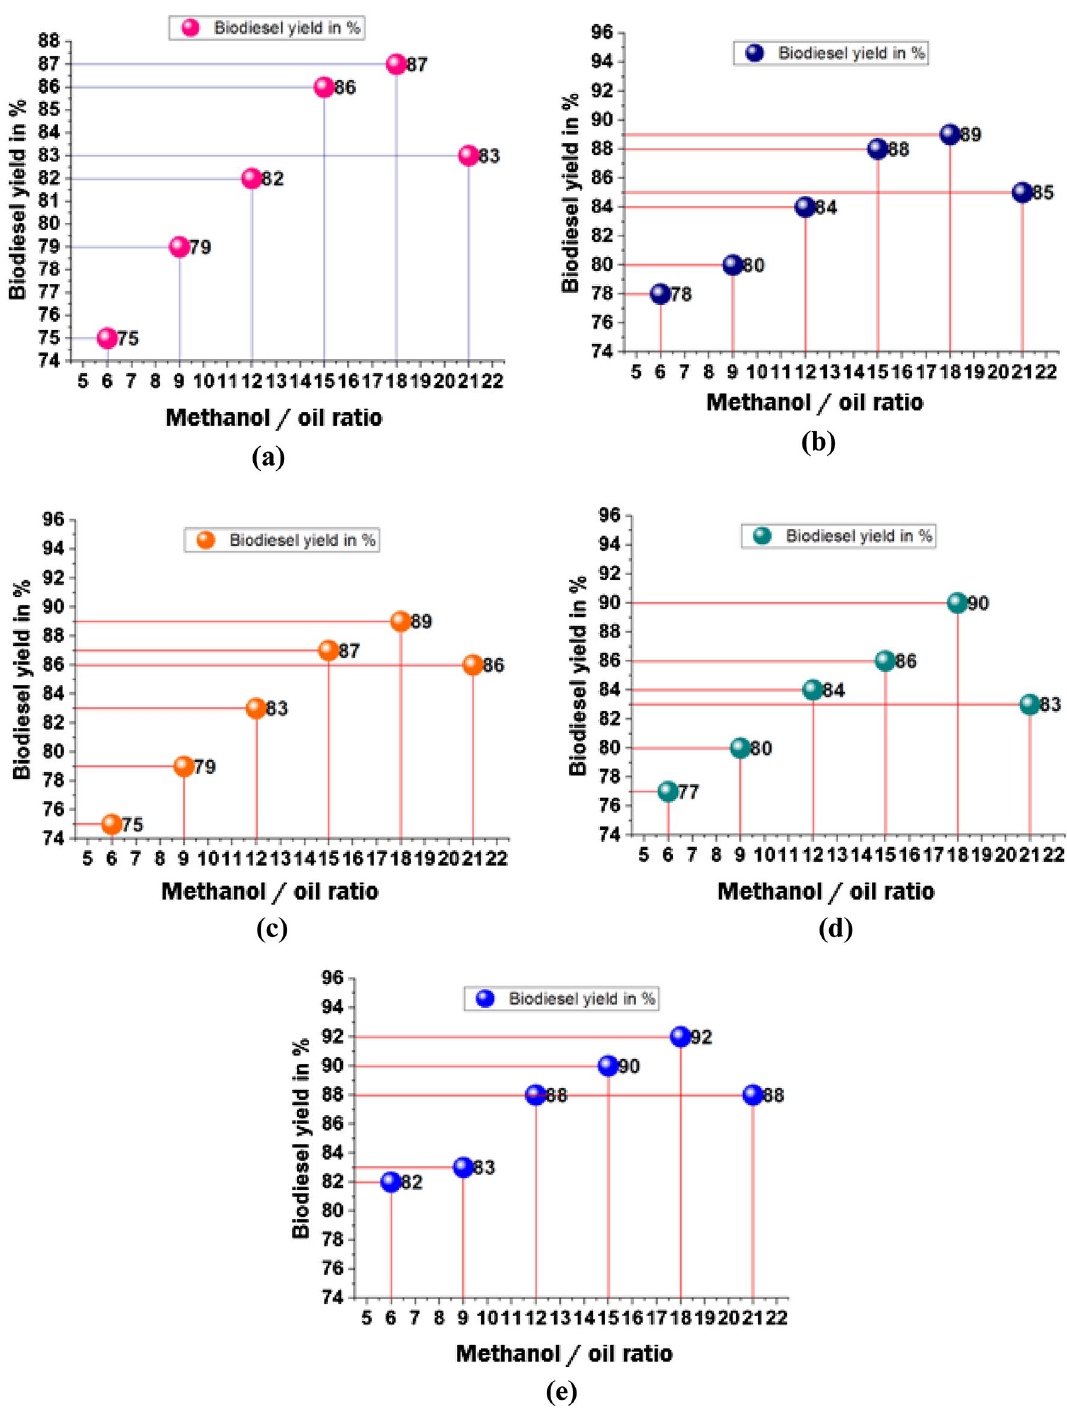
Figure 6. Methanol /oil ratio vs. biodiesel yield in % using of plant waste: ( a ) Bagasse ( b ) Papaya stem ( c ) Banana peduncle ( d ) Moringa oleifera ( e ) Mixed